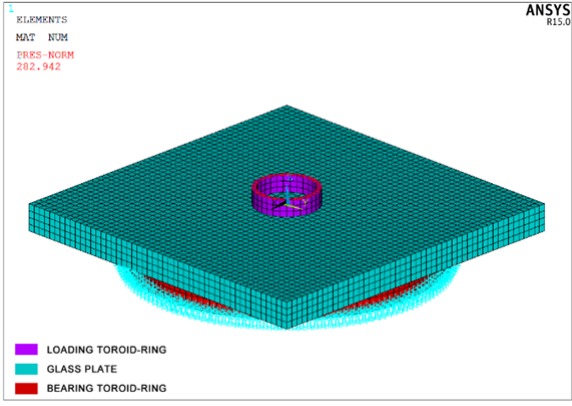
Fig. 1FEM model: mesh